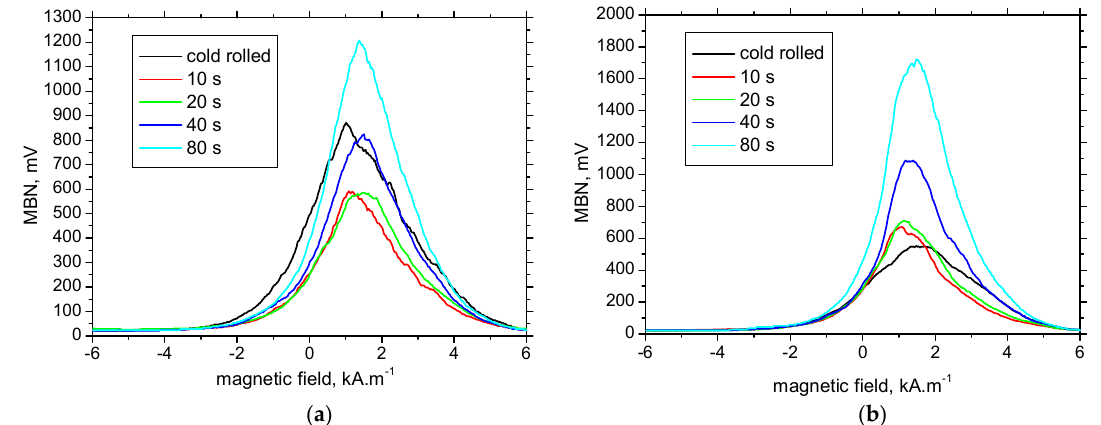
Figure 8. MBN envelopes for the RD and TD directions. ( a ) RD direction, ( b ) TD direction.